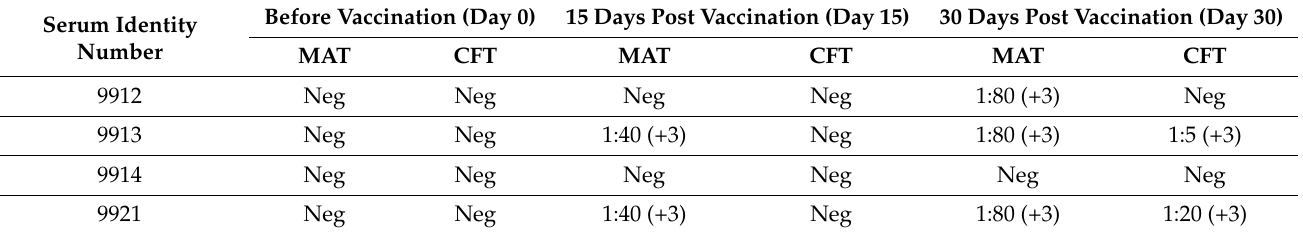
Table 1. Anti- Brucella -OPS serum titers depicted by MAT and CFT in the first vaccine experiment before and after ocular vaccination with B. melitensis Rev. 1